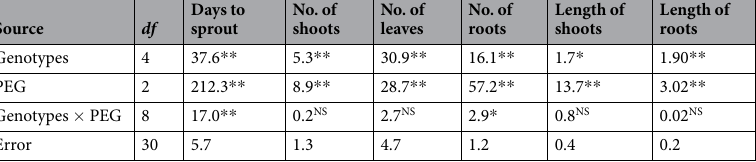
Table 1. Two way analysis of variance for growth parameters of Chinese potato genotypes under in vitro PEG mediated osmotic stress conditions in a 5 × 3 factorial experiment in complete randomized design (fCRD). * , **